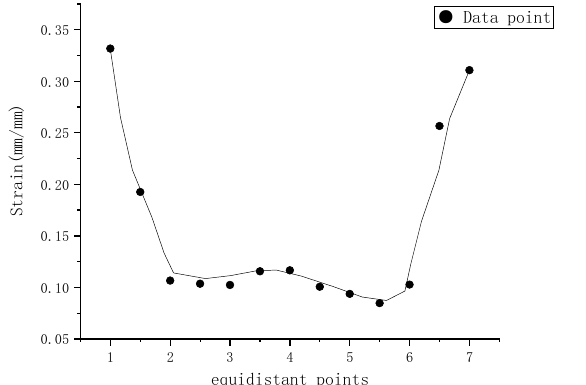
Figure 11. Stress distribution of data points of dissimilar lightweight materials welded joint along thickness direction.